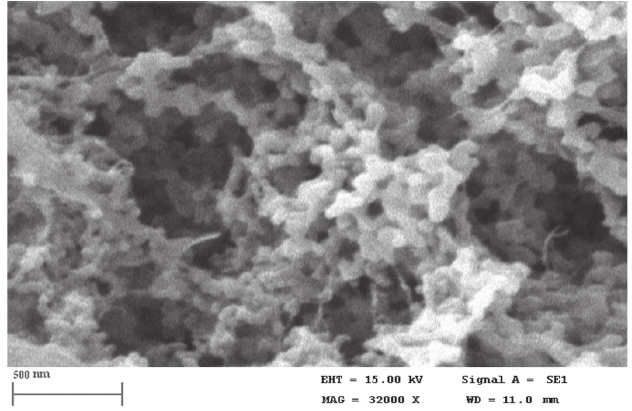
FIGURE 3 - 1 HNMR of the prazosin (A), PEG (B), PEG‑succinic acid (C), PLGA (D), PEG‑Praz (E).